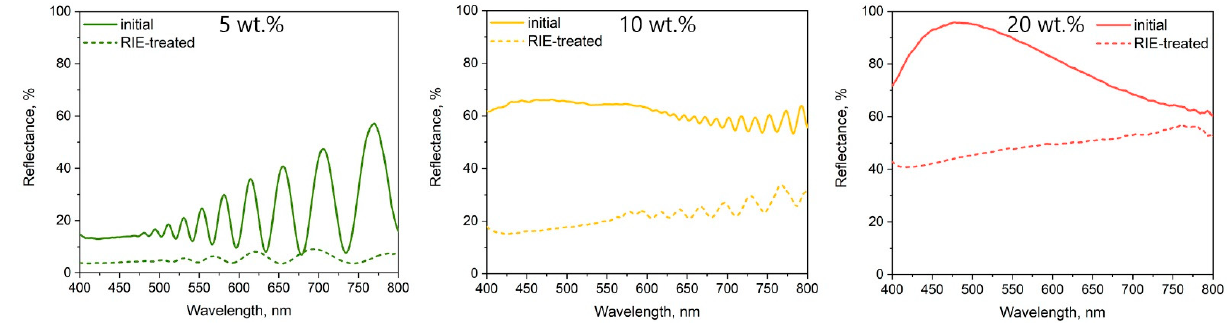
Figure 6. Reflectance spectra of initial PS (solid line) and RIE-treated (dashed line) formed at j = 60 mA/cm 2 in the electrolyte with HF concentration of 5 wt.%, 10 wt.%, 20 wt.%. Table 1. The Average Refractive Index of Initial and RIE-treated PS. HF Conc.